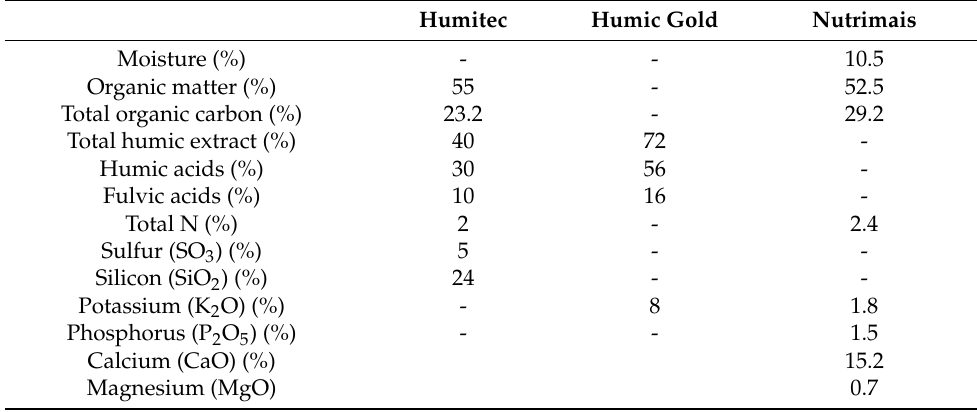
Table 1. Properties of the organic amendments used in these experiments (data provided by the